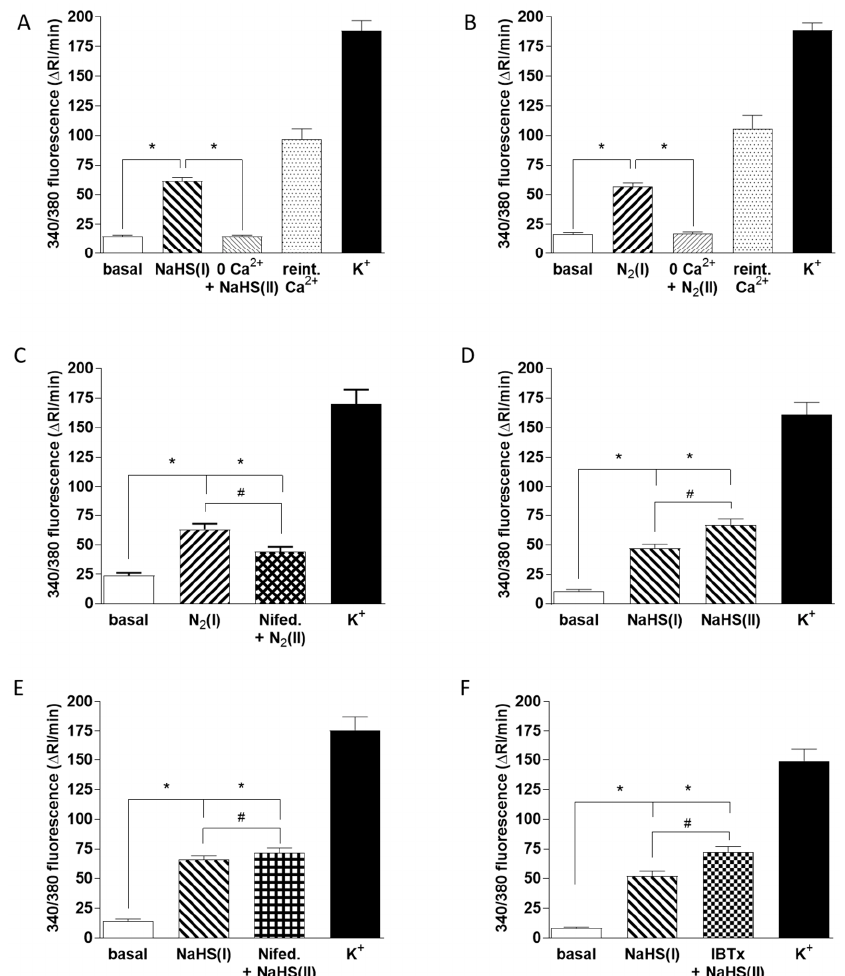
Figure 6. Mechanisms of Ca 2+ influx induced by hypoxia and 50 µM NaHS. [Ca 2+ ] i was assessed as the F340/F380 fluorescence emission ratio in isolated chemoreceptor cells loaded with fura-2. In all cases the protocols followed the same pattern: a first exposure to hypoxia or NaHS, subsequent application of the experimental condition 0 mM Ca 2+ (1 min, A , B ), 2 µ M nifedipine (3 min, C and E ), or 100 nM IBTx (1 min, F ) followed by that condition with hypoxia or NaHS and finally high K + to demonstrate that cells were viable. Bars in all panels indicated the running integrals of the fluorescence signals ( ∆ fluorescence/min) obtained during the various conditions. ( A ) Effect of Ca 2+ free solution on the Ca 2+ signal caused by NaHS (n = 66 cells). ( B ) Effect of Ca 2+ free solution on the Ca 2+ signal evoked by hypoxia (n = 44 cells). In both cases, Ca 2+ reintroduction caused a rebound increase in the fluorescence emission ratio. ( C ) Effect of nifedipine on the Ca 2+ signal elicited by hypoxia (n = 24 cells). ( D ) Ca 2+ signals evoked by two successive exposures of cells to NaHS under control conditions, data from 51 cells. ( E ) Ca 2+ signals evoked by two successive exposures of cells to NaHS—the first under control conditions and the second in the presence of nifedipine (n = 50 cells). ( F ) Ca 2+ signals evoked by two successive exposures of cells to NaHS; the first under control conditions and the second in the presence of IBTx (n = 47 cells). Symbols connote significant differences between the columns